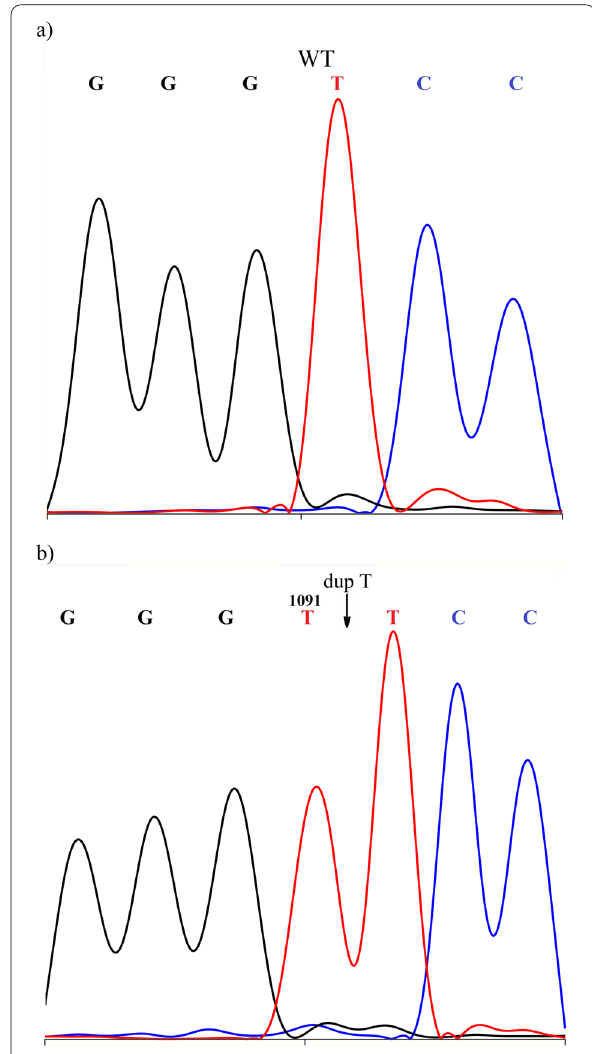
Fig. 2 Genetic sequencing of the LHCGR gene. a Sanger sequencing of DNA control individuals (Wild Type; WT) and b homozygous duplication mutation c.1091dupT in